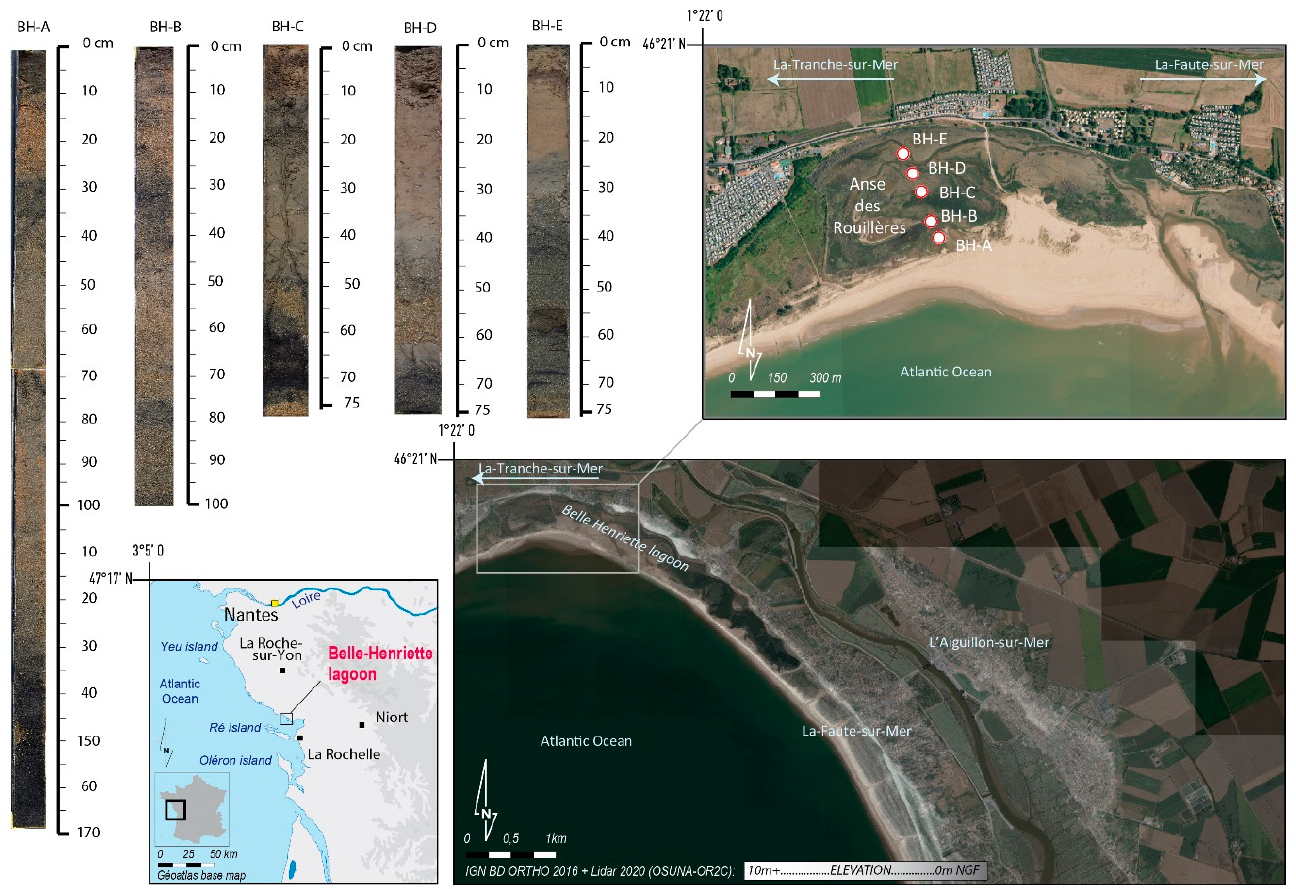
Figure 1. Presentation of the Belle Henriette lagoon and photograph of the five extracted cores. The aerial photograph was extracted from Google Earth, the BD ortho comes from the IGN, and topographic data are the result of the OSUNA-OR2C team work.